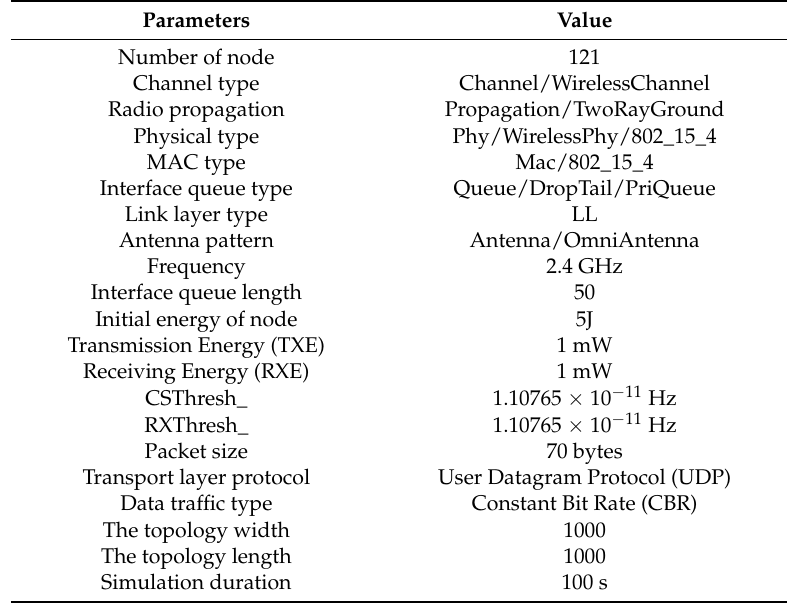
Table 2. Network parameters used in